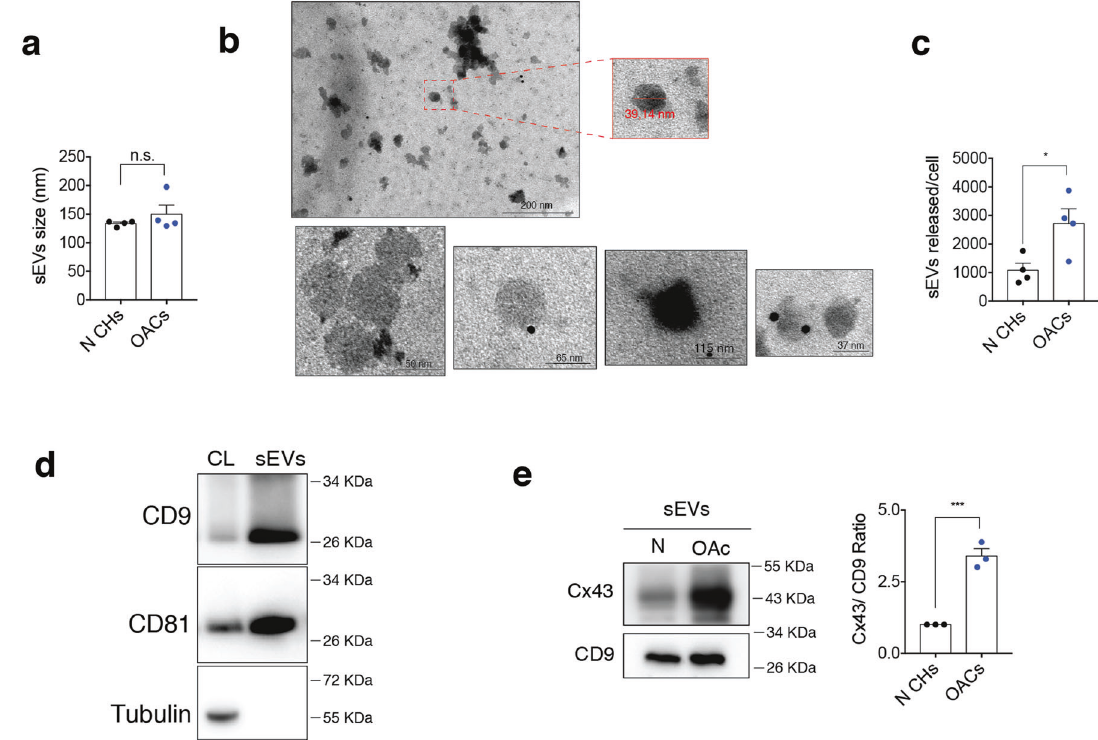
Fig. 1 Human osteoarthritic chondrocytes secrete sEVs containing high levels of Cx43. a Average size in nm of sEVs released by healthy (N CHs) and OA-derived chondrocytes, determined by nanoparticle tracking analysis (NTA). n = 4, Student ’ s t test. b Representative electron microscopy images of CD9-immunogold labelling from sEVs derived from OA chondrocytes. c Number of sEVs released by healthy and OA chondrocytes after 72 h, detected by NTA. n = 4, Student ’ s t test. d Representative images of the sEVs markers CD9 and CD81 in sEVs derived from OA chondrocytes. e sEVs derived from OA chondrocytes display increased levels of Cx43 when compared to sEVs derived from healthy chondrocytes. n = 3, Student ’ s t test. Data are expressed as mean ± S.E.M., * P < 0.05, *** P <